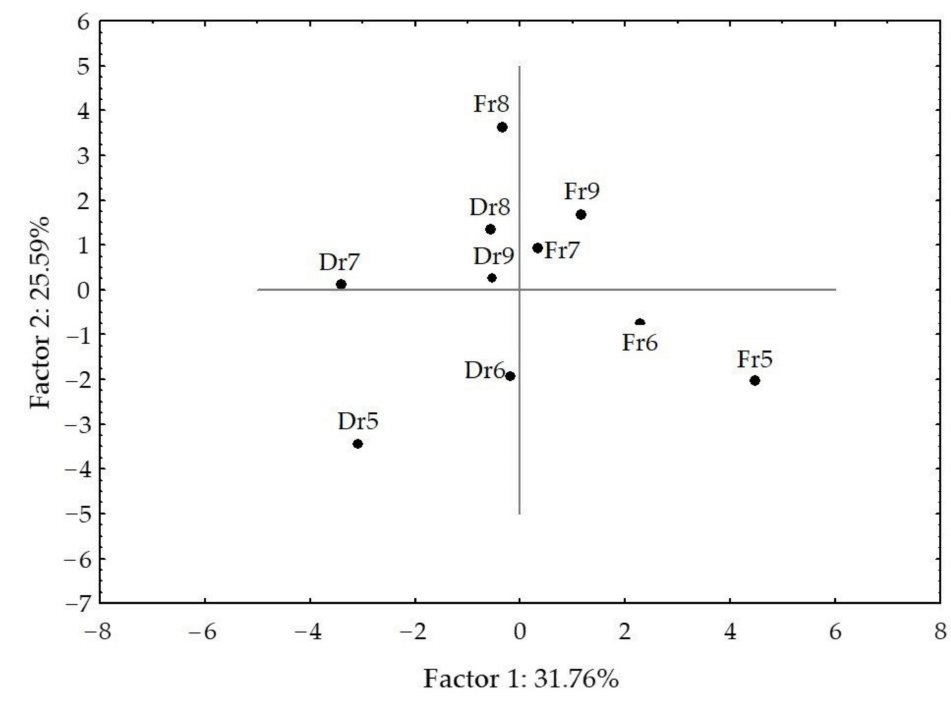
Figure 10. Score plot of the dominant VOCs of fresh (Fr) and air-dried (Dr) H. scoparia samples obtained by hydrodistillation.